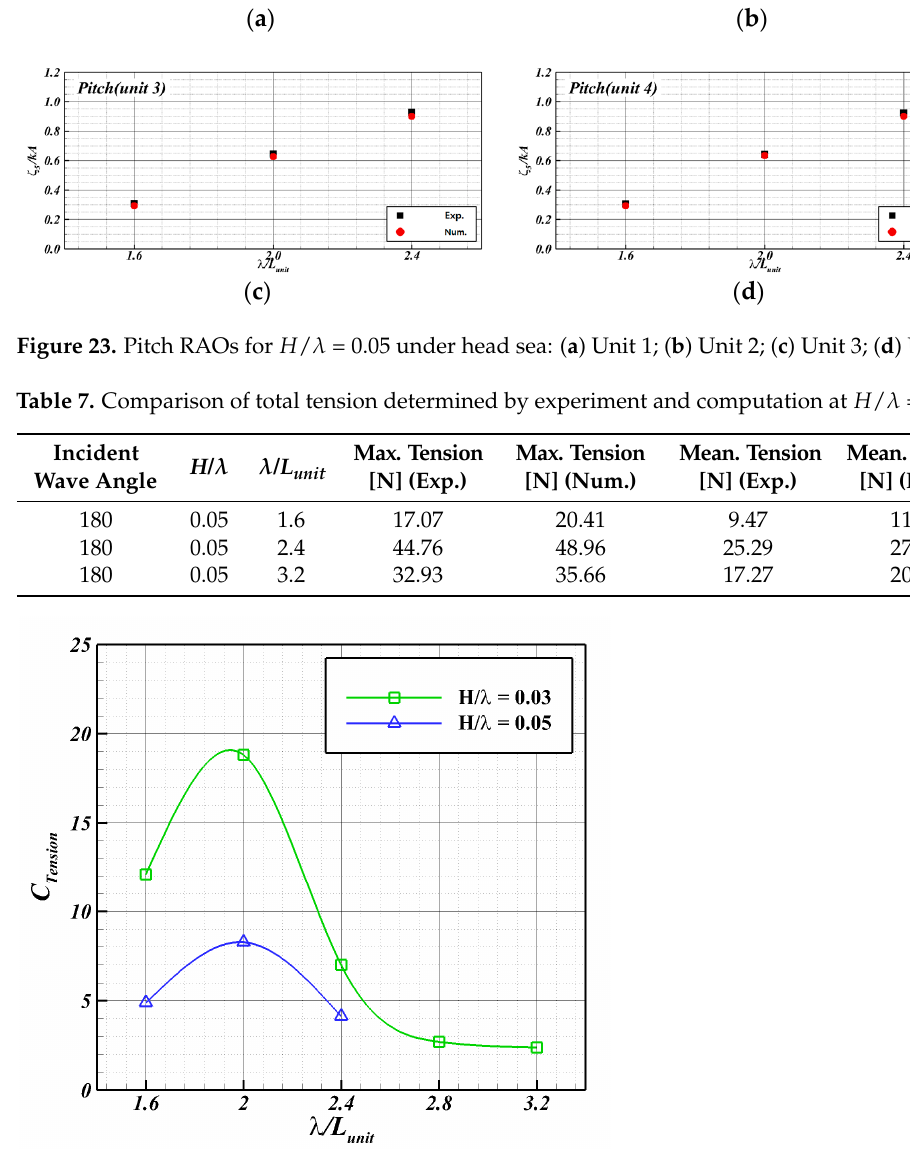
Figure 22. Heave RAOs for 𝑯/𝝀 = 0.05 under head sea: ( a ) Unit 1; ( b ) Unit 2; ( c ) Unit 3; ( d ) Unit 4. Figure 23. Pitch RAOs for 𝑯/𝝀 = 0.05 under head sea: ( a ) Unit 1; ( b ) Unit 2; ( c ) Unit 3; ( d ) Unit 4. Table 7. Comparison of total tension determined by experiment and computation at 𝑯/𝝀 = 0.05. Incident 𝑯/𝝀 Wave Angle